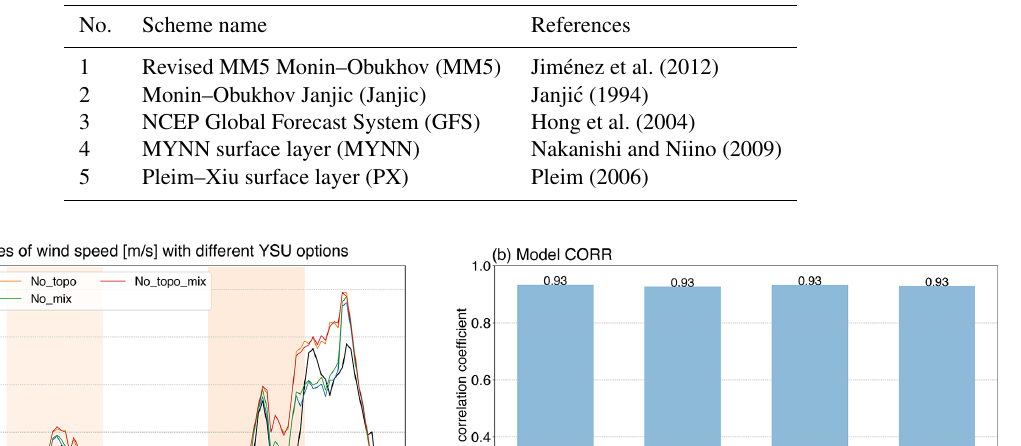
Table 4. List of surface schemes investigated in this study.